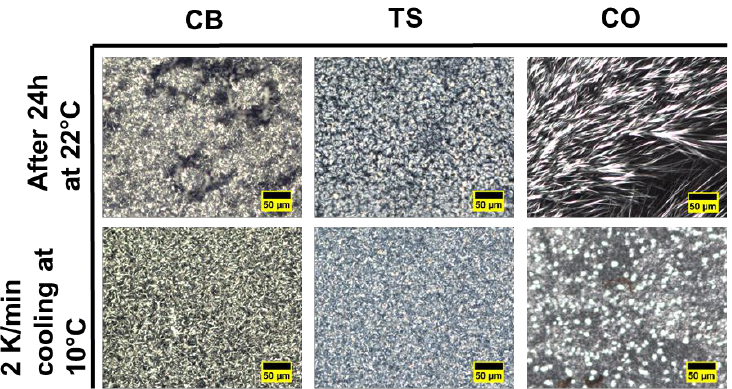
Figure 8. PLM analysis of pure fats after isothermal crystallization at 22 °C for 24 h and dynamic crystallization at 10 °C by cooling down with 2 K/minute rate. Scale bar = 50 µm. crystallization at 10 ◦ C by cooling down with 2 K / minute rate. Scale bar = 50 µ